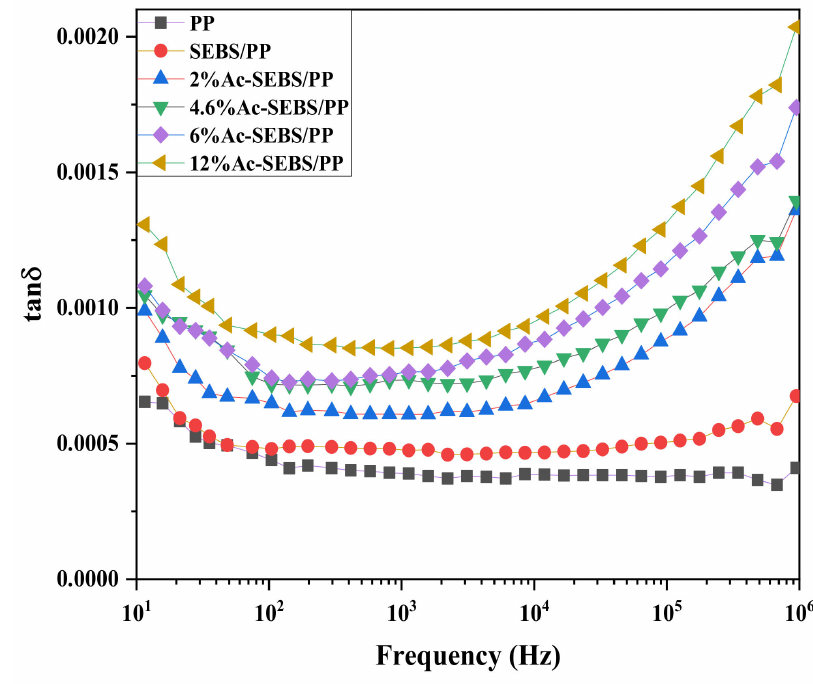
Figure 11. Dielectric loss spectrum of PP and its composite